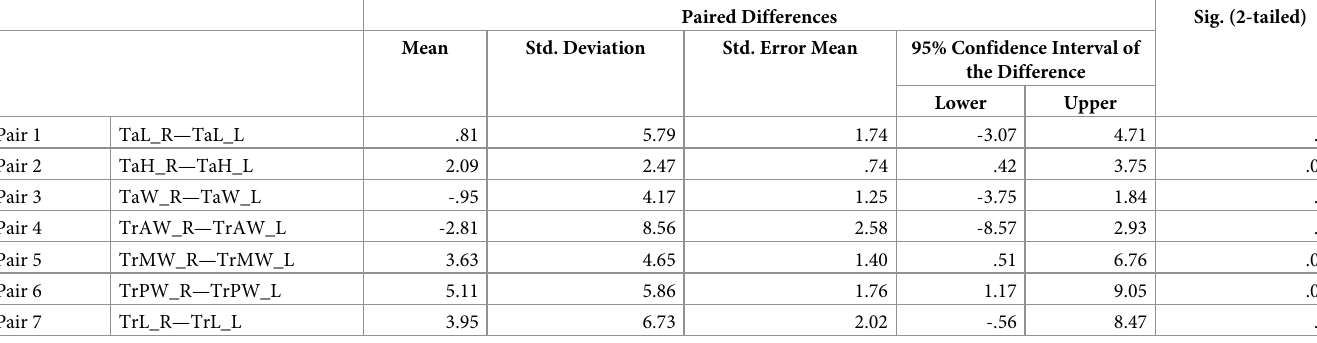
The present study highlights the morphometric geometric variations between the right and left tali in matched pairs of fresh human cadaveric ankles. The results demonstrated significant differences between the left and right matched-pair talar morphometric profiles, specifically in Table 2. The morphometric differences of talus from 11 matched pairs of tali. Paired Differences Sig. (2-tailed) Mean Std. Deviation Std. Error